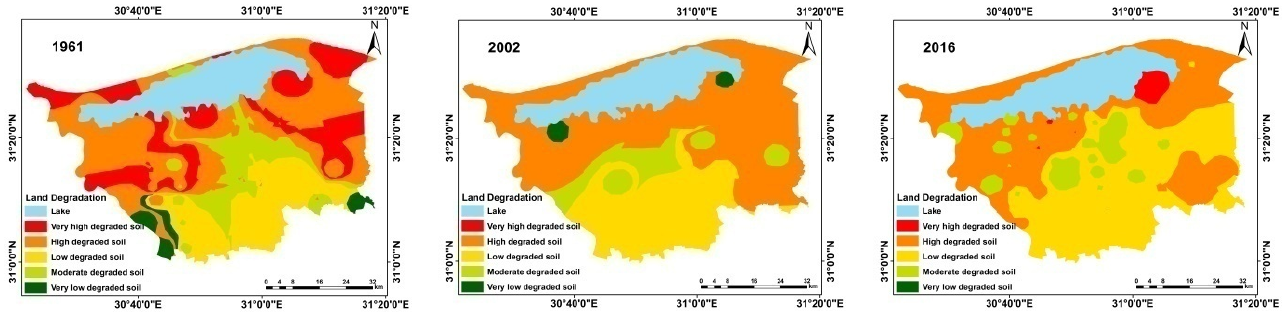
Figure 15. Overall qualitative soil degradation in 1961, 2002, and 2016.